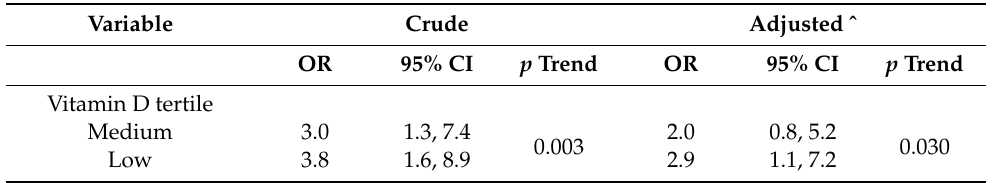
Table 4. Odds ratio of the association between vitamin D concentrations and insulin resistance in Mexican children and adolescents. Variable Crude OR 95% CI p